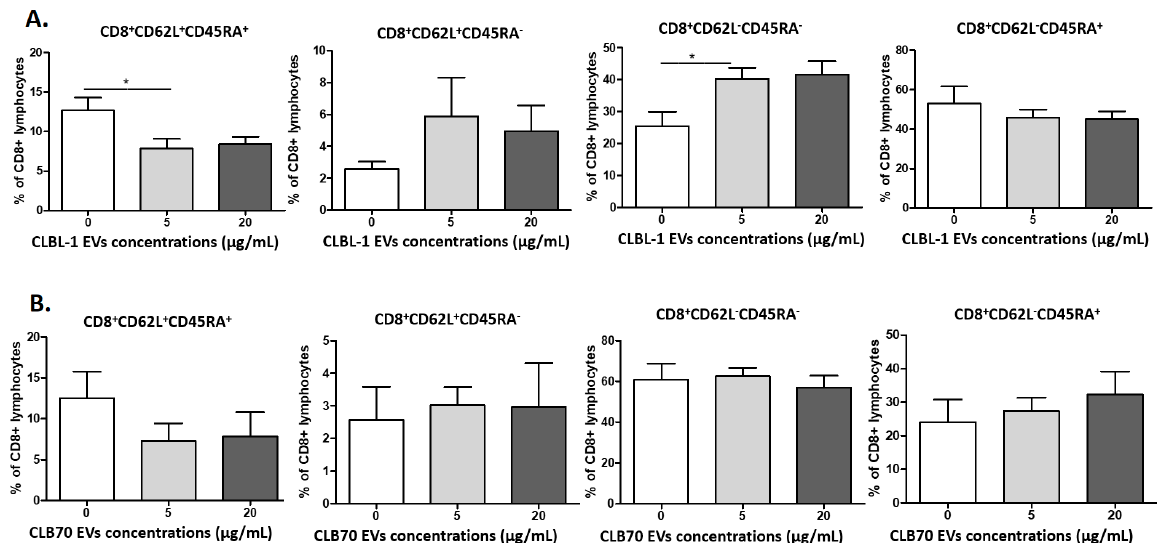
Figure 5. Influence of TEVs on the percentage of activated memory CD8 + lymphocytes. Changes in frequencies of canine CD4 + and CD8 + lymphocytes after 5 days culture of PBMCs in a 37 °C, 5% CO 2 environment with ConA and IL-2 in the presence of CLBL-1 EVs ( A ) and CLB70 EVs ( B ) in two concentrations or without TEVs (n = 7). The results are presented as the mean ± SEM. The significance level is: * p < 0.05.